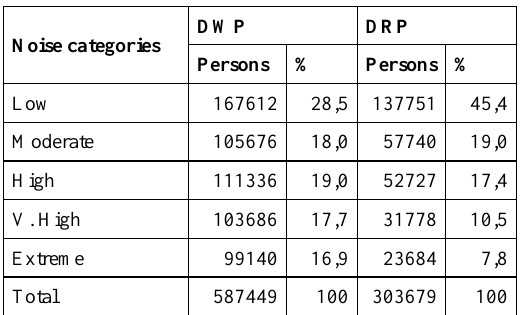
Table 4. Daytime worker (DWP) and residential (DRP)